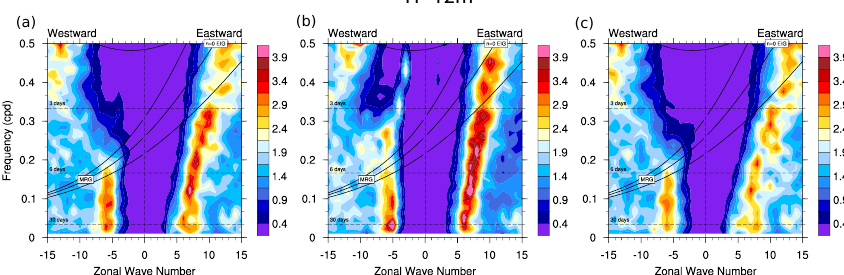
Figure 15. Wavenumber-frequency spectrum of the 200 hPa meridional wind field associated with the mixed Rossby-gravity modes having ( a ) the full vertical mode spectrum, ( b ) a barotropic structure in the troposphere ( m ≤ 5), and ( c ) a baroclinic structure in the troposphere ( m ≥